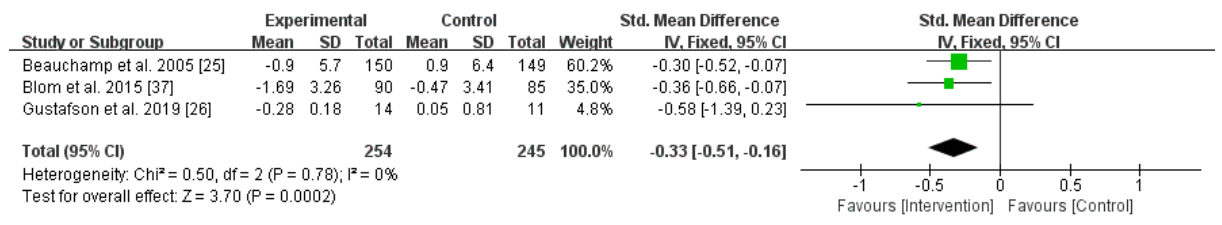
Figure 8. The effect of internet-based supportive interventions on